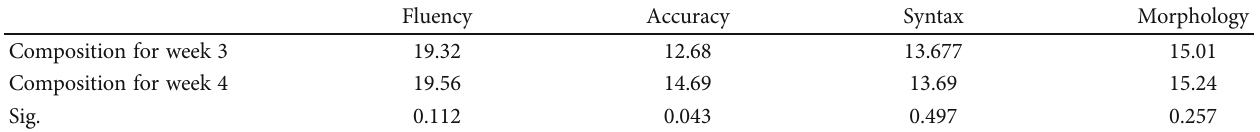
Table 6: Wechsler ’ s signed-rank test of composition for weeks 3 and